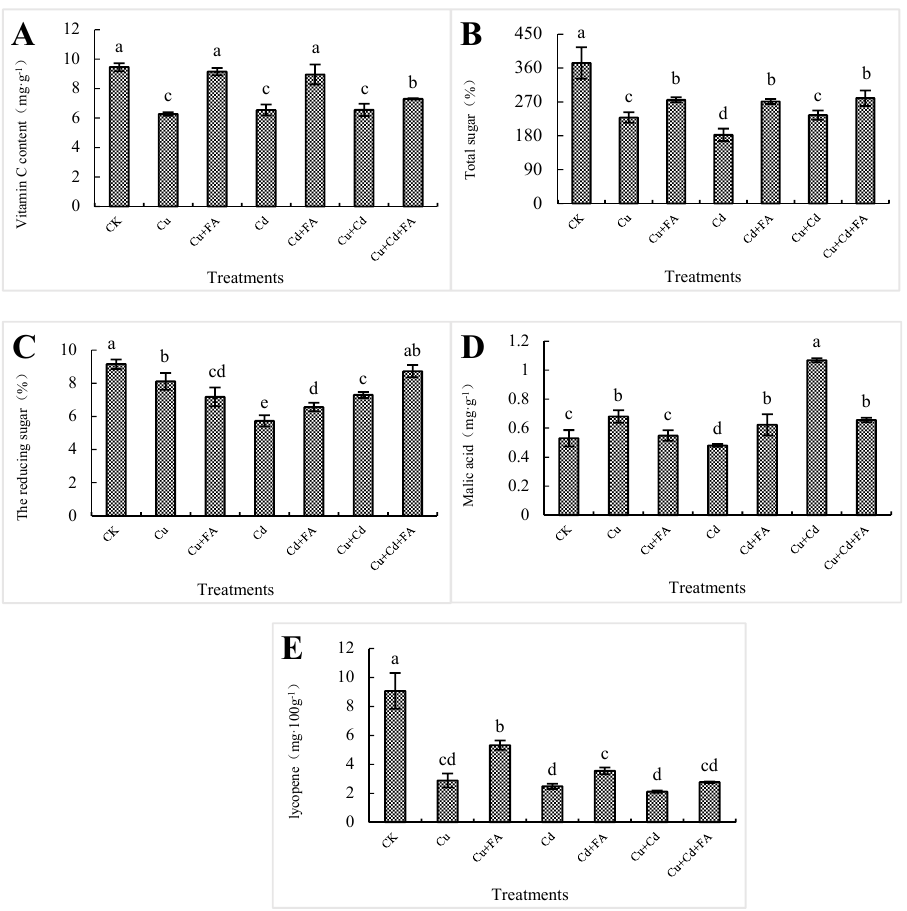
Figure 4. The content of Vc ( A ), total sugar ( B ), reducing sugar ( C ), malic acid ( D ) and lycopene ( E ) of tomato fruit under different Cu, Cd stress. The same alphabet above each column shows no sig- nificance ( p > 0.05), in contrast, having significance ( p < 0.05).